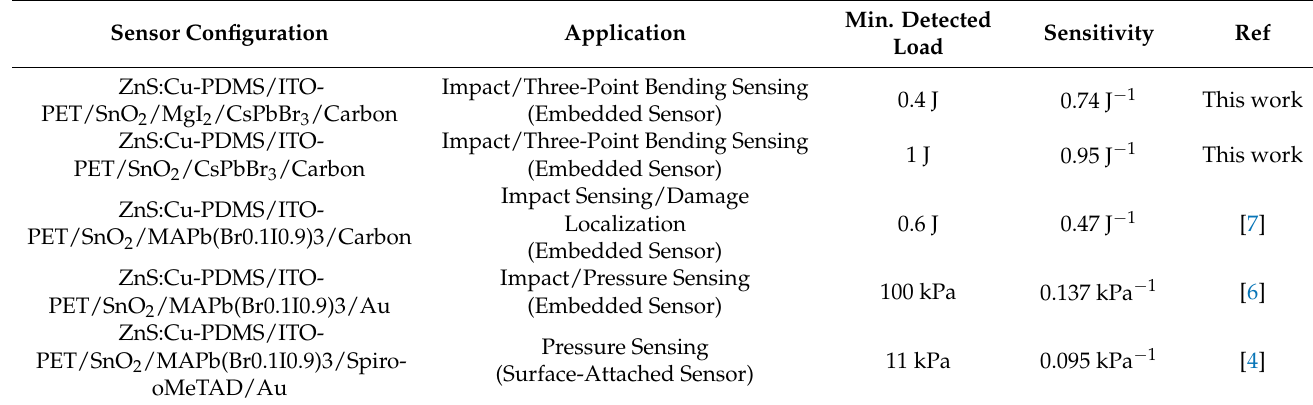
Table 3. Summary of the performance of different ML-perovskite